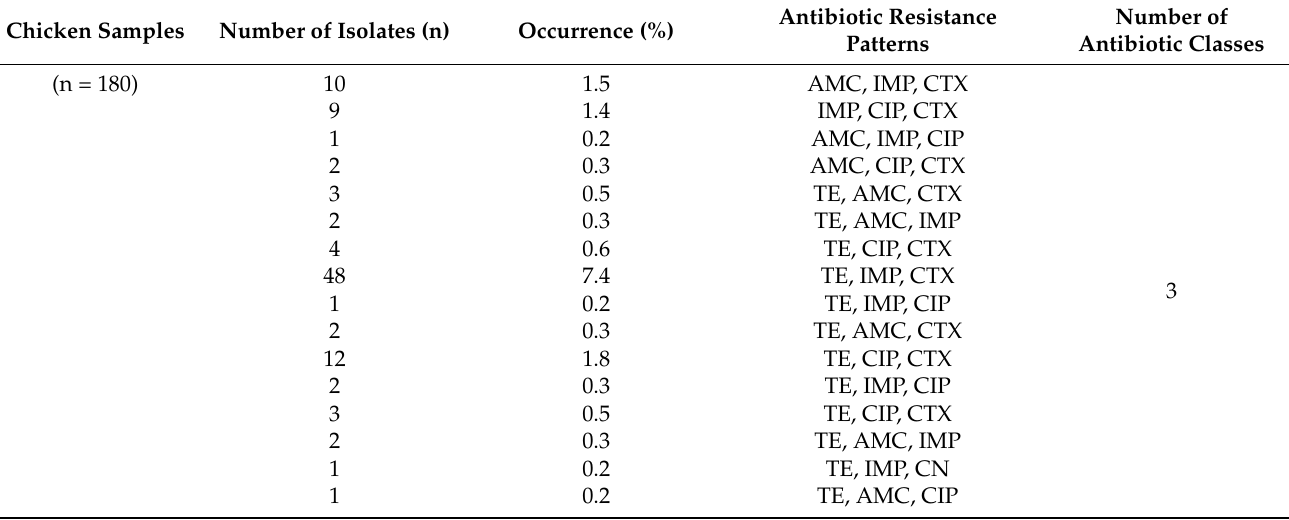
Table 4. Resistance patterns of 180 MDR E. coli isolates from chicken samples.